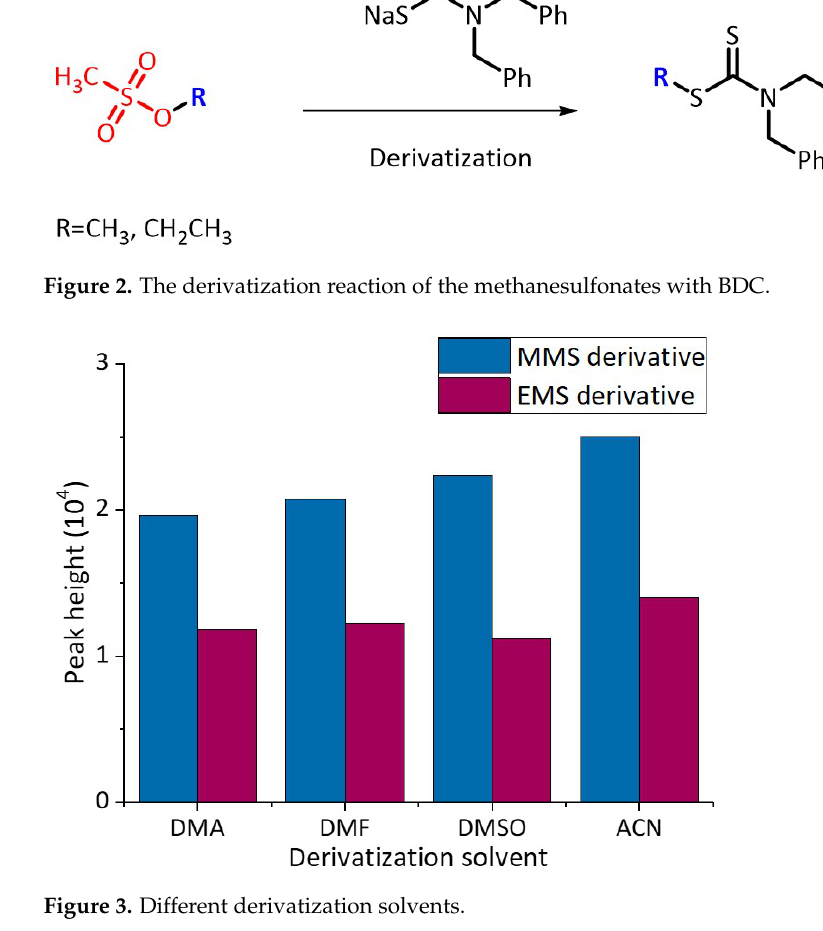
Figure 3. Different derivatization solvents.